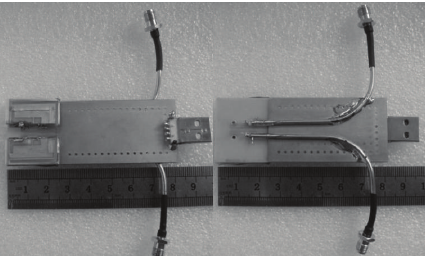
Figure 5: Photograph of the fabricated multiband MIMO antenna.